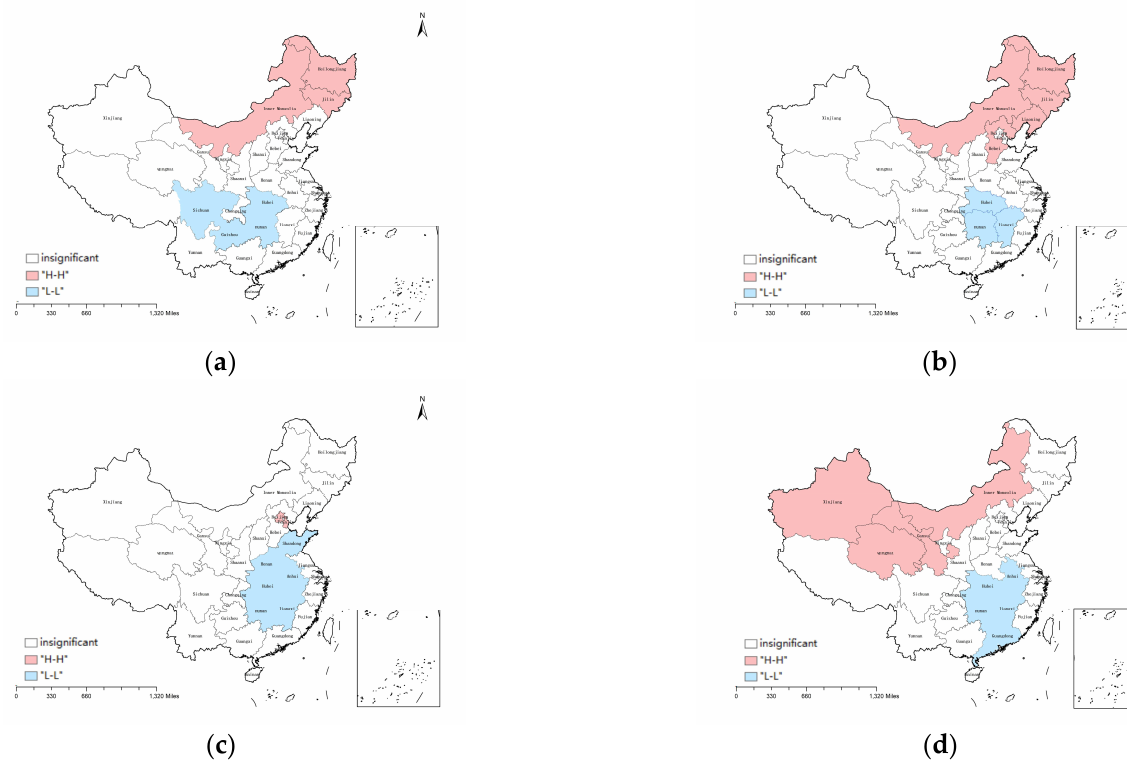
Figure 9. Local indicators of spatial association (LISA) cluster maps of coupling coordination degree in 2010 and 2020. Note: ( a ) Total coupling coordination (D1) in 2010. ( b ) Intensity of coupling coordination (D2) in 2010. ( c ) Total coupling coordination (D1) in 2020. ( d ) Intensity of coupling coordination (D2) in 2020.